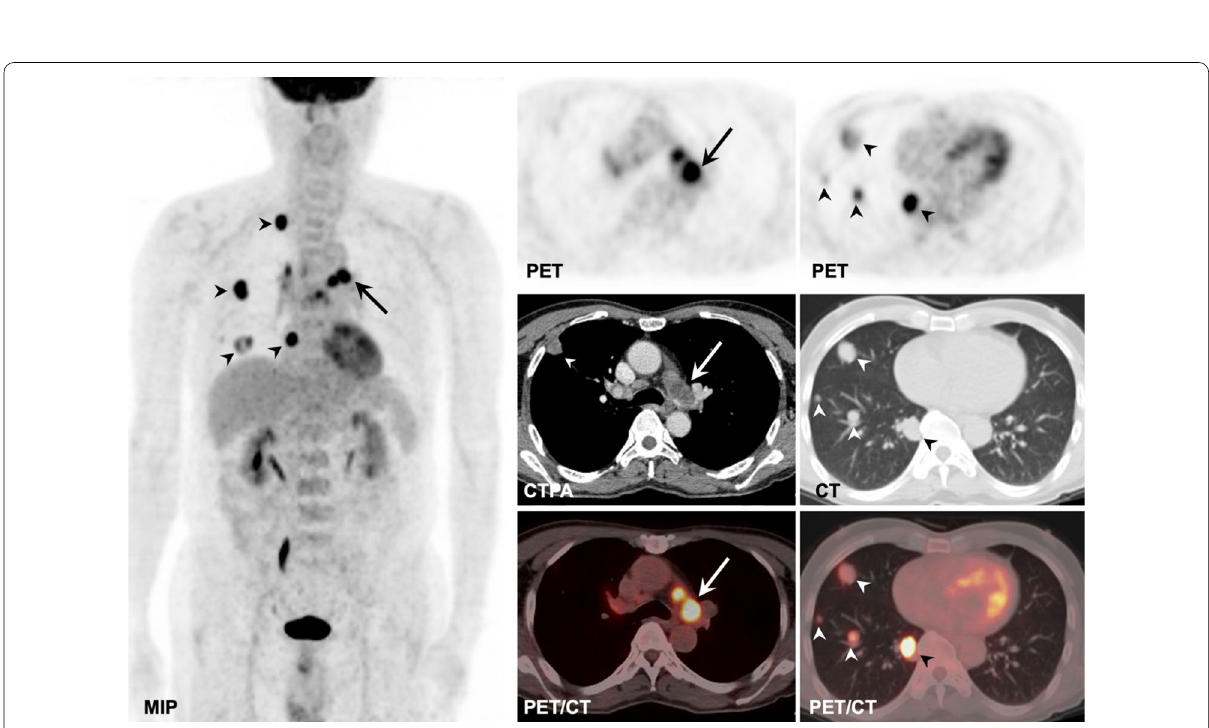
Fig. 4 PAS in a 67-year-old man involving PT, RPA, and LPA (solid arrows) with SUVmax of 11.3 on the MIP, axial PET, and fused PET/CT images and filling defect on the CTPA image, with the metastases of right lung (arrowheads) on the MIP, axial PET, CT, and fused images and mediastinal and right hilar lymph